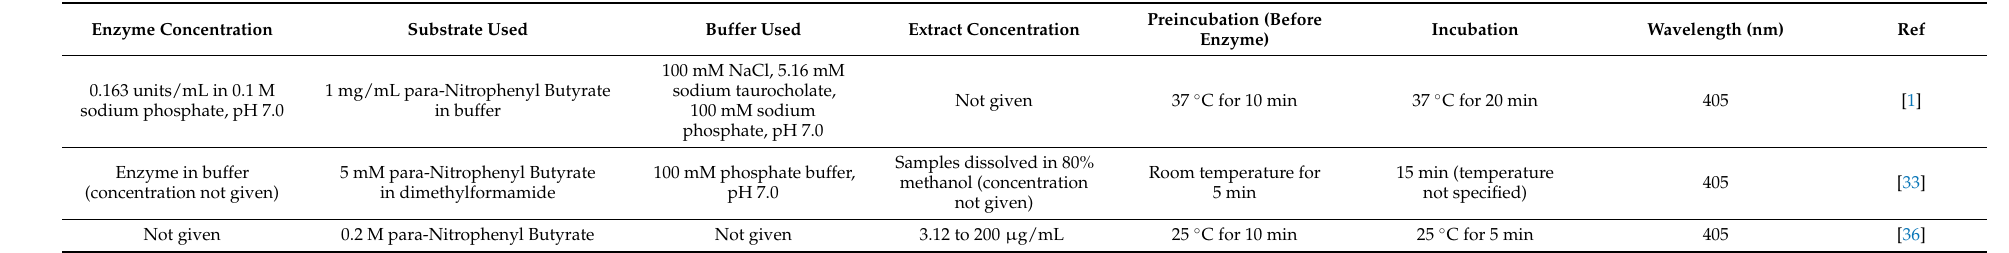
Table 3. Conditions used during the screening for cholesterol esterase inhibitors using plant